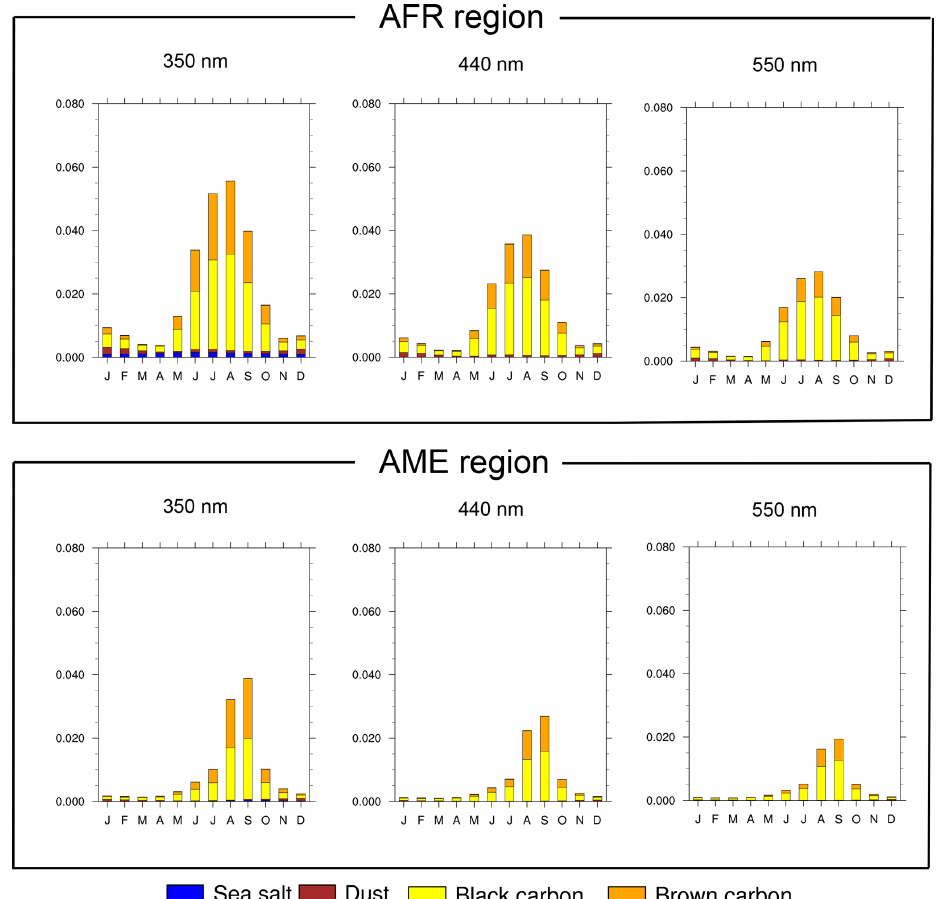
Figure 7. AAOD (350, 440, and 550nm) of the different absorbing aerosols over the AFR and AME regions (BRC simulation; see Table 3 for